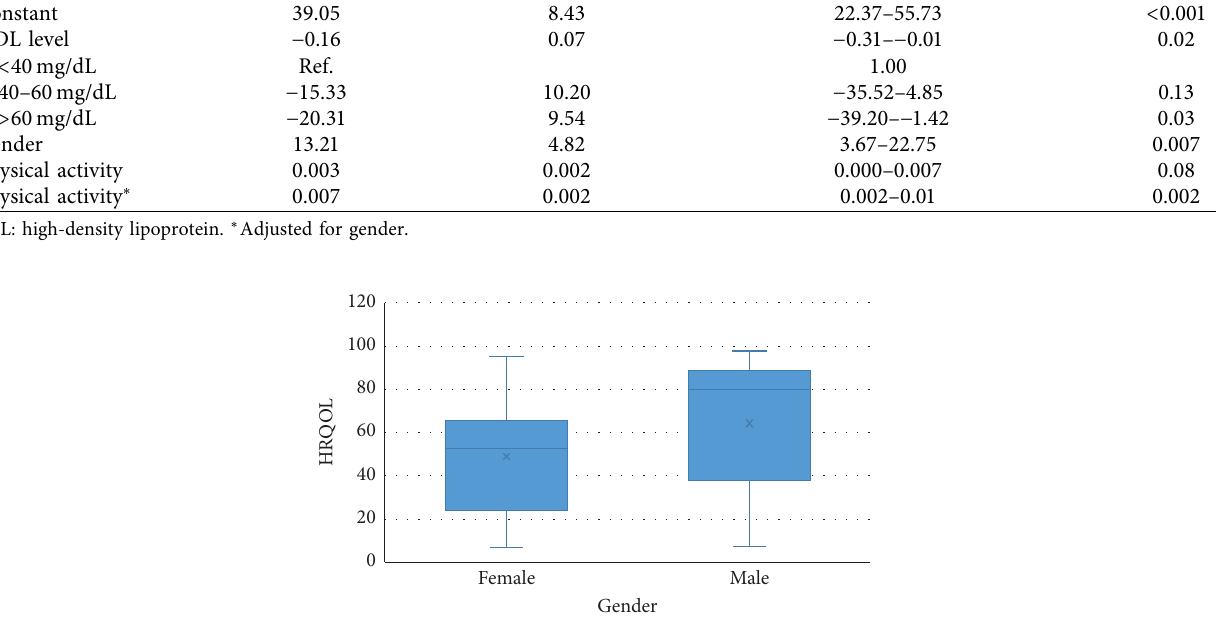
Figure 1: Association between gender and HRQOL.